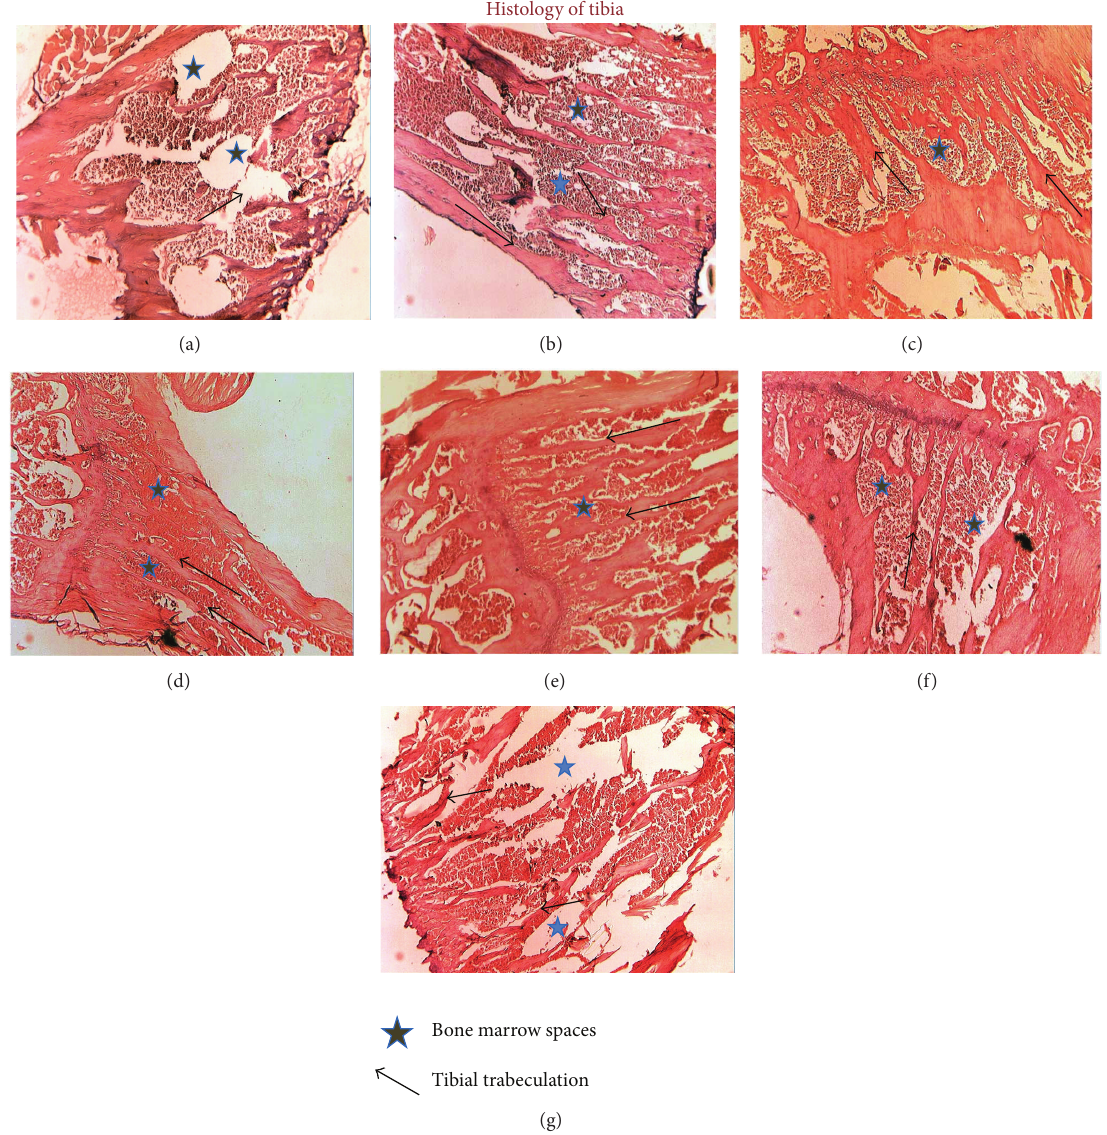
Figure 2: Histological study of the tibial trabeculation after the ovariectomy and EAME treatment. Ovariectomised mice were orally administered with EAME for 30 days. The tibia was harvested after the termination of administration of the extract. The tibia was formalin- fixed, decalcified, dehydrated in alcohol, fixed in paraffin, and Hematoxylin and Eosin stained (magnification 10x). (a) OVX control, (b) Sham control, (c) estradiol treated group, (d) EAME 200 mg/kg, (e) EAME 100mg/kg, (f) EAME 50 mg/kg, and (g) EAME 25 mg/kg, where blue star indicates bone marrow spaces. Black arrow indicates tibial